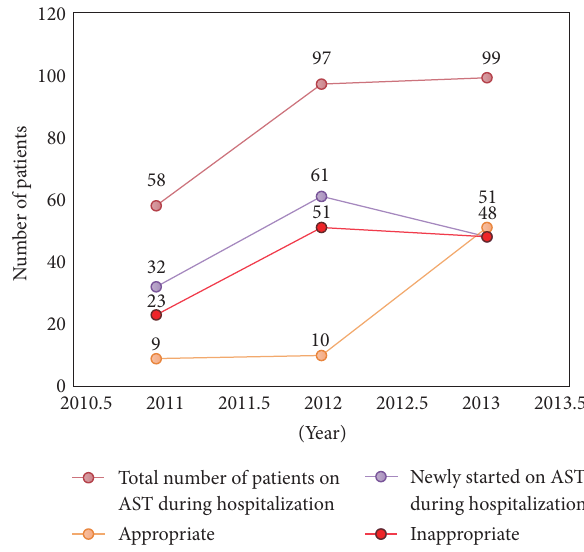
Figure 2: AST use at discharge during 2011–2013. AST: acid suppressive therapy.